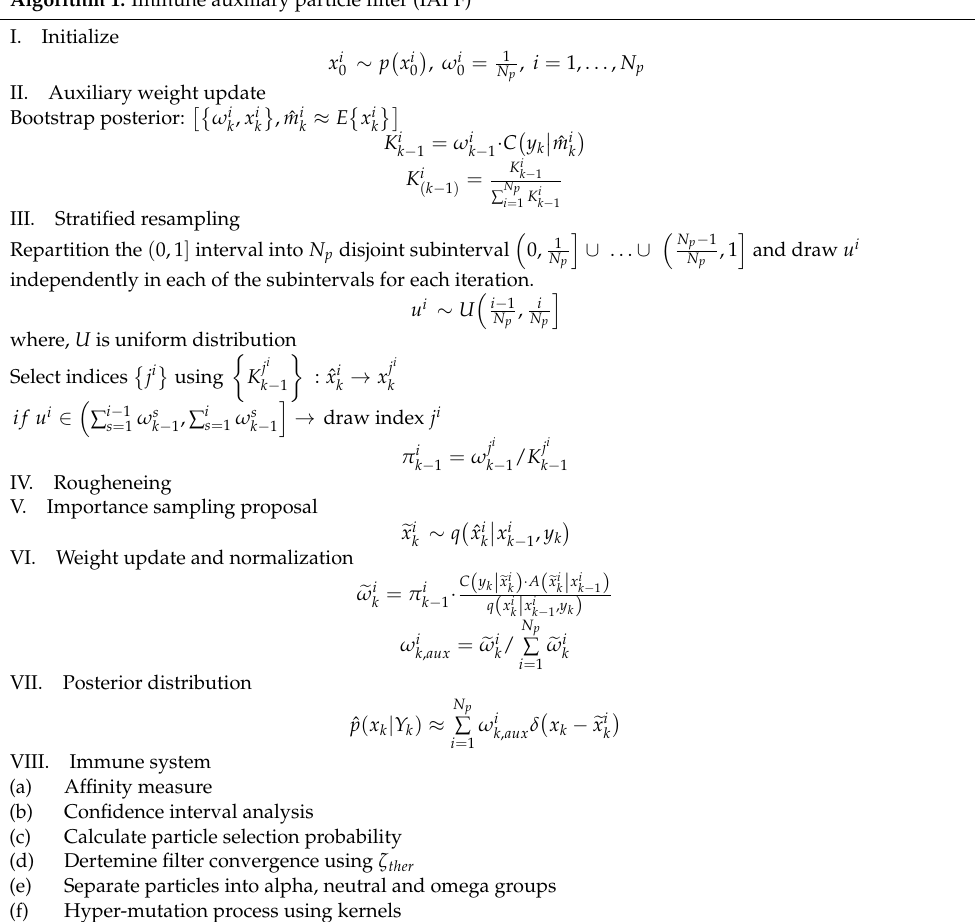
Algorithm 1: Immune auxiliary particle filter